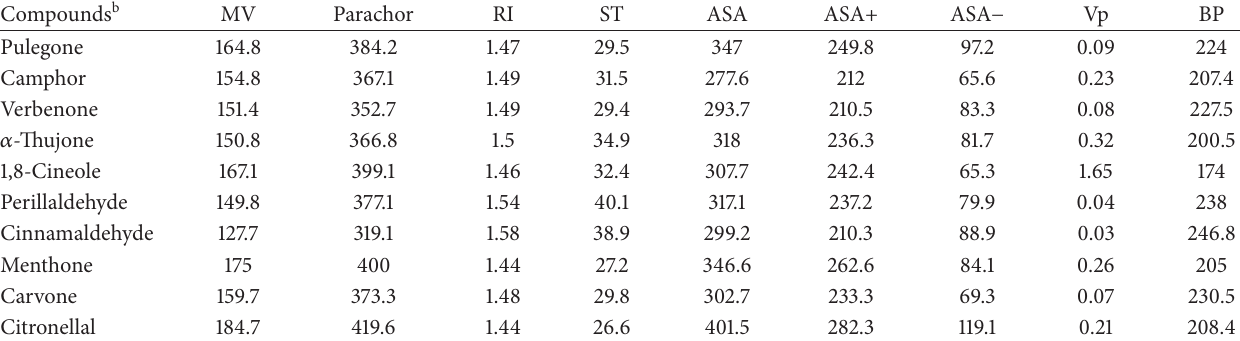
Table 4: Calculated molecular descriptors a for aldehyde and ketone compounds used in QSAR analysis of the insecticidal activity against